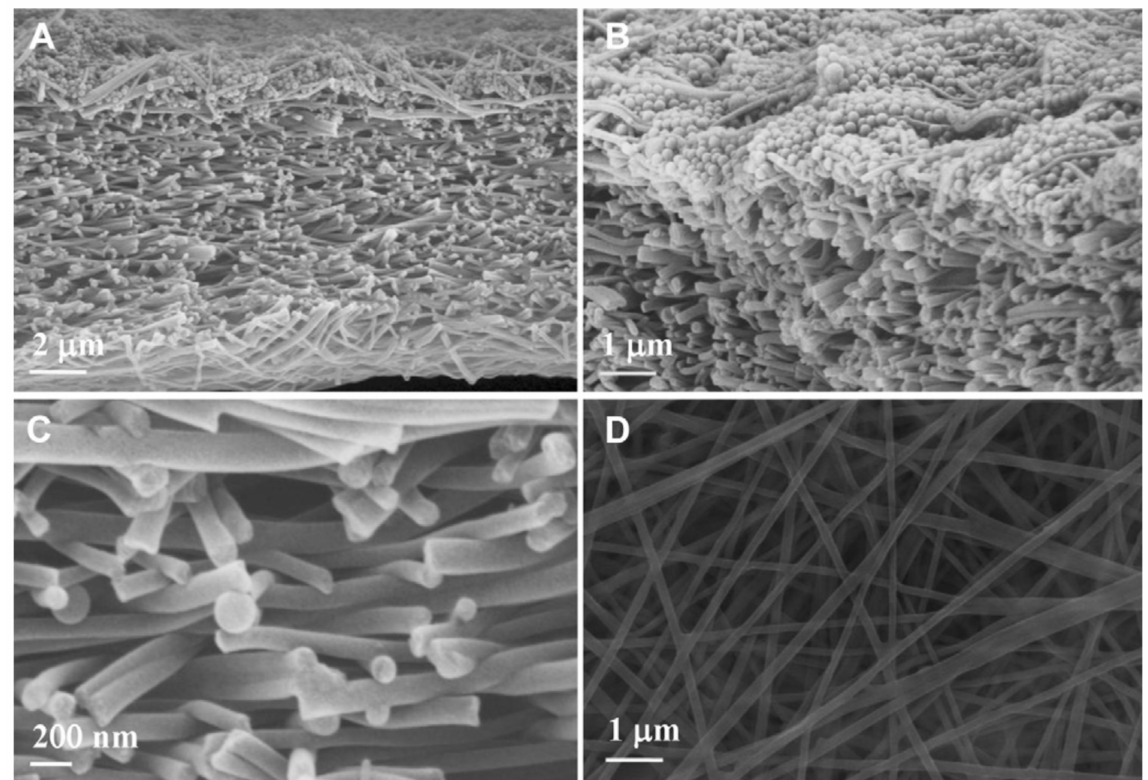
Figure 3. SEM images of the M2 membrane after particle rejection test in different views: ( A ) cross- section; ( B ) top layers of cross-section; ( C ) middle part of cross-section; ( D ) bottom surface. Provided with permission from Elsevier